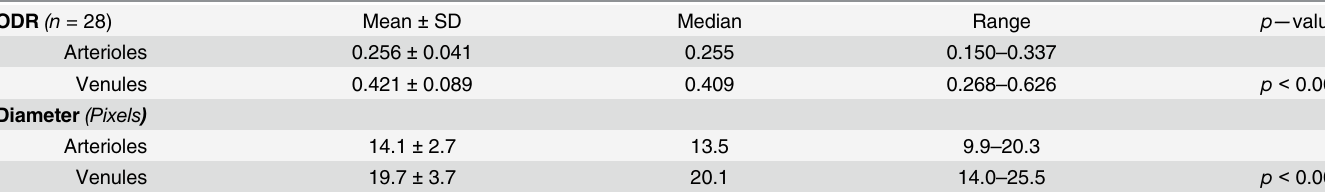
Table 2. Optical Density Ratio (ODR) and Vessel Width of the Retinal